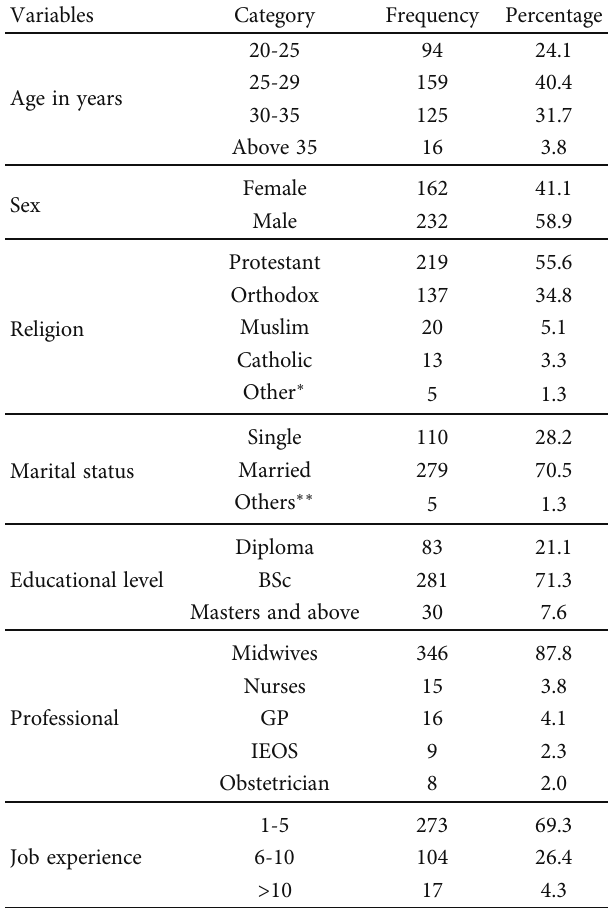
Table 1: Sociodemographic characteristics of obstetric care providers who participated in the study and worked in public hospitals of Sidama region, Ethiopia, 2022 ( N = 394